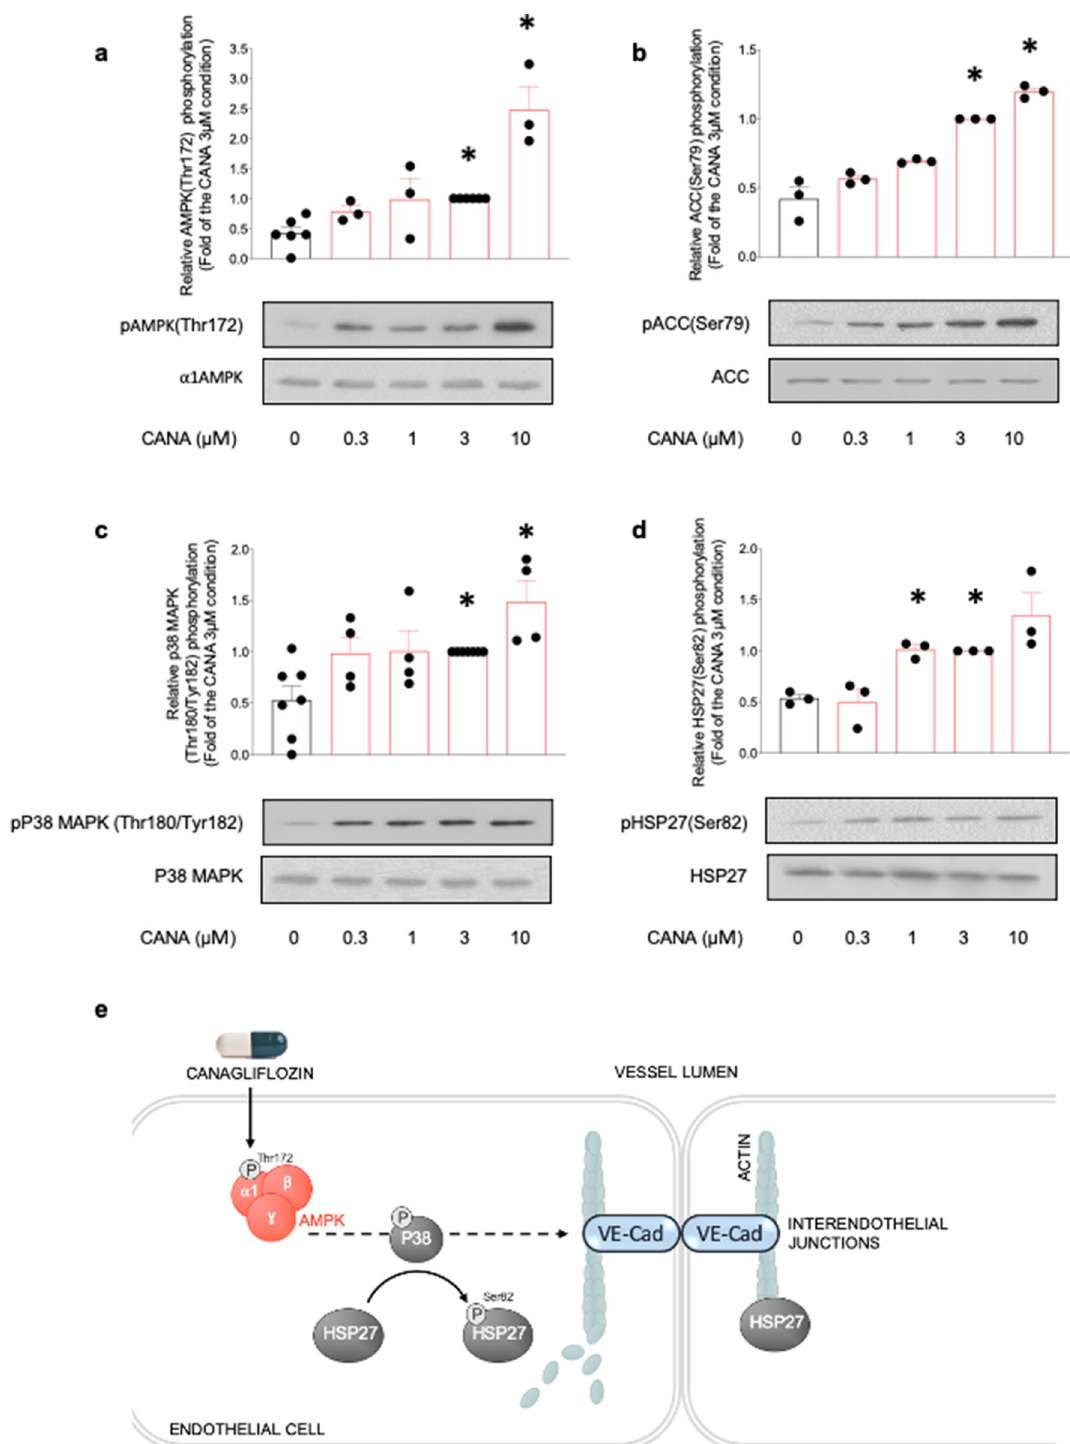
Figure 3. Canagliflozin activates the ⍺ 1AMPK/p38MAPK/HSP27 pathway in HMECs. HMECs were treated with canagliflozin (Cana) for the indicated concentrations during one hour. Cell lysates were submitted to western blot analysis and probed with total and phosphorylated ( a ) ⍺ 1AMPK (Thr172), ( b ) ACC (Ser79), ( c ) p38 MAPK (Thr180/Tyr182) and ( d ) HSP27(Ser82) antibodies, ( e ) Molecular mechanisms underlying the protective action of canagliflozin on interendothelial junctions. Representative western blots and quantification are shown. Data are fold of the 3 µM condition and expressed as mean ± SEM (3 to 6 biological replicates for each condition). * p < 0.05 is relative to untreated HMECs. The data underwent one-way